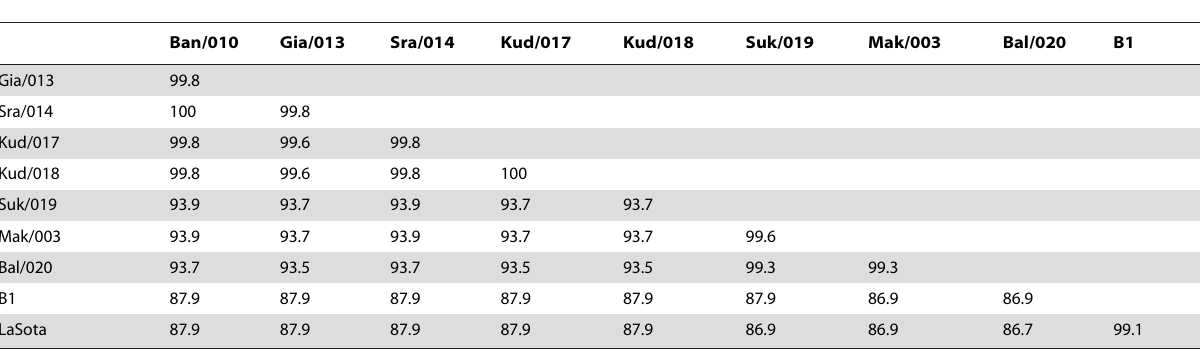
Table 3. Identities of amino acid sequences of HN protein.